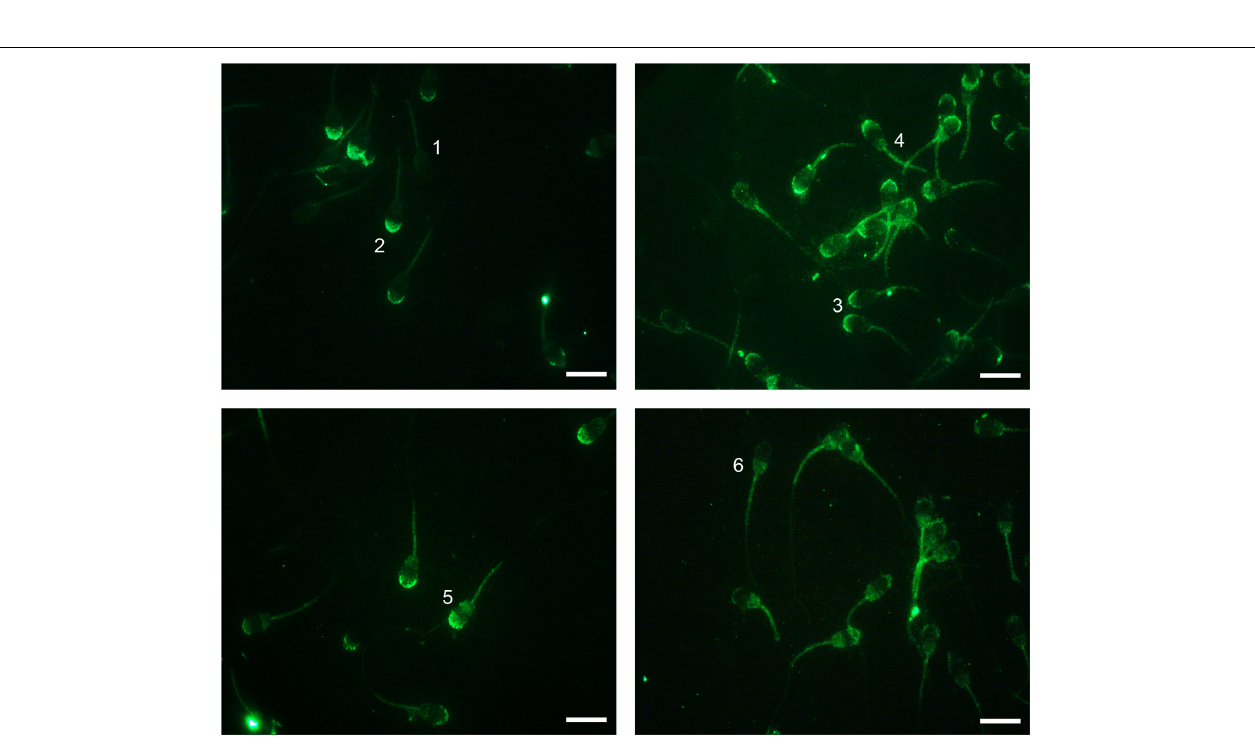
FIGURE 2 | Indirect immunofluorescence (IIF) localization of NOX5 evaluated by fluorescence microscopy in ram spermatozoa. Six immunotypes can be seen: labeling in midpiece (1); in the acrosomal region (2); in the apical edge (3); in the apical edge + postacrosomal region (4); in the acrosomal and postacrosomal regions (5); and in the postacrosomal region (6). All of them present midpiece labeling. Original magnification × 1,000. Scale bars = 10 µ m.